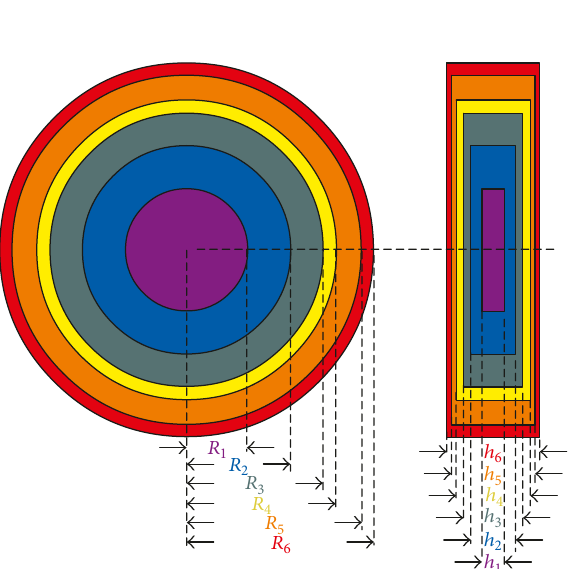
Figure 1: Transformed Luneburg lens structure showing the six layers.